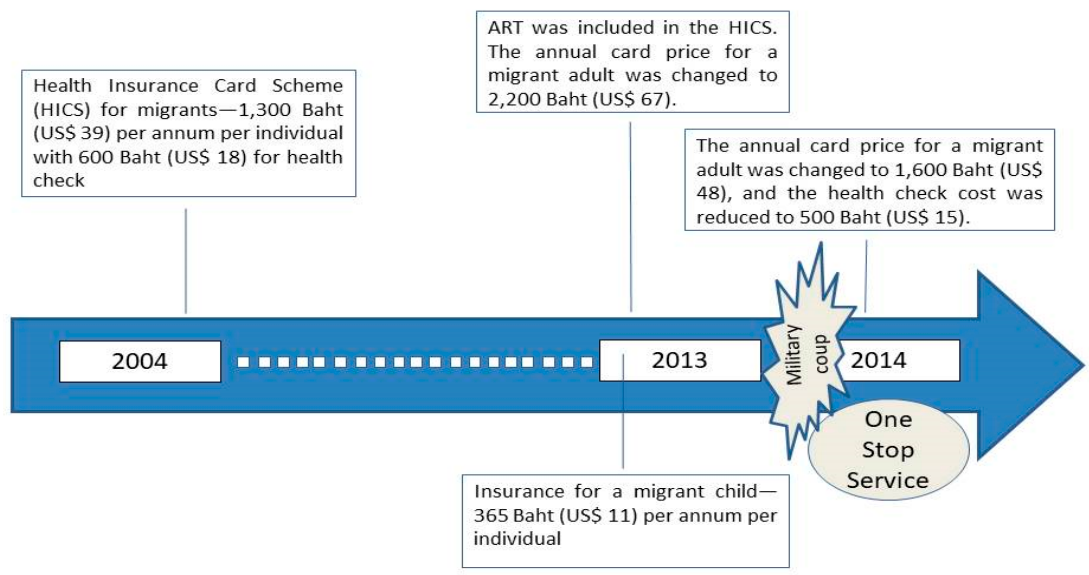
Figure 1. Chronological evolution of the ‘Health Insurance Card Scheme’ for migrants. Source: adapted from Health Insurance Group [11].